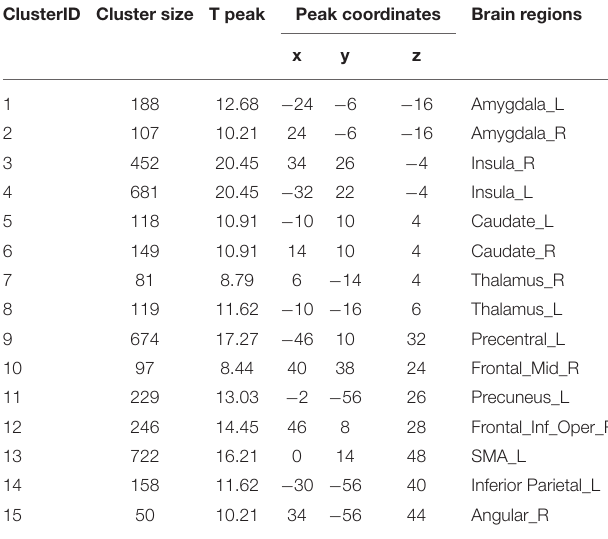
TABLE 1 | Coordinates of schizophrenia (SCZ) ROIs identified from